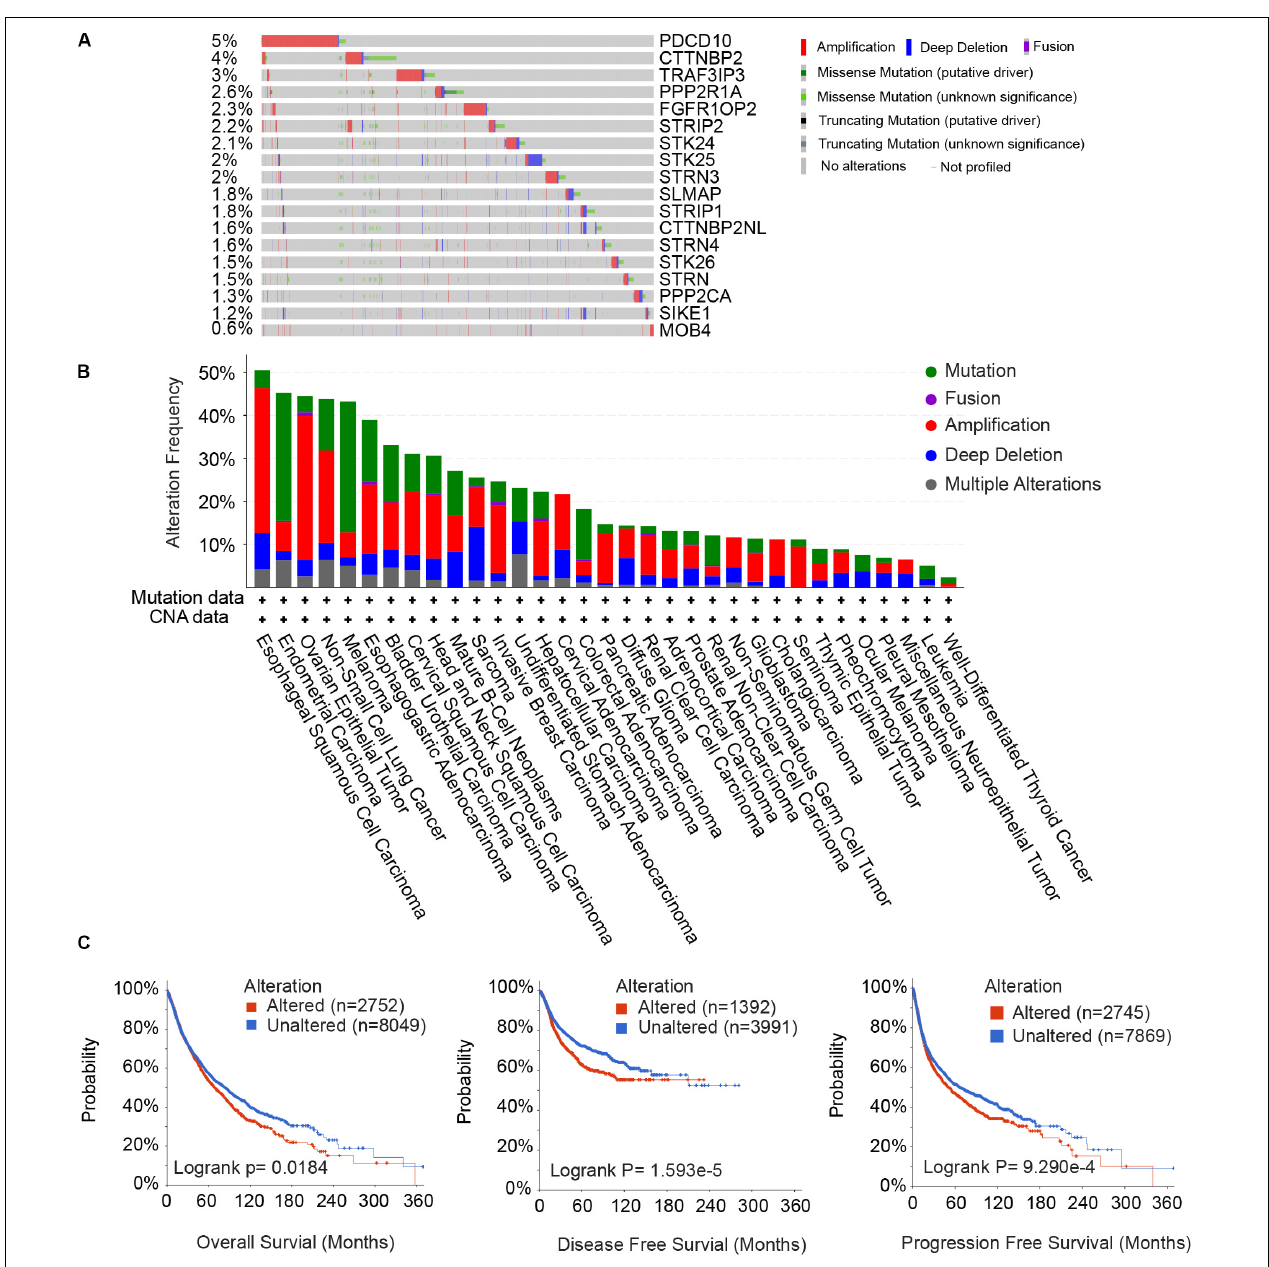
FIGURE 2 | Somatic alterations of the STRIPAK complex. (A,B) Waterfall plots (A) and distribution (B) of gene mutation and copy number alteration of 18 STRIPAK genes. (C) Kaplan-Meier analysis of overall survival, disease-free survival and progression-free survival for patients with or without genetic mutations of STRIPAK. All data are from cBioportal